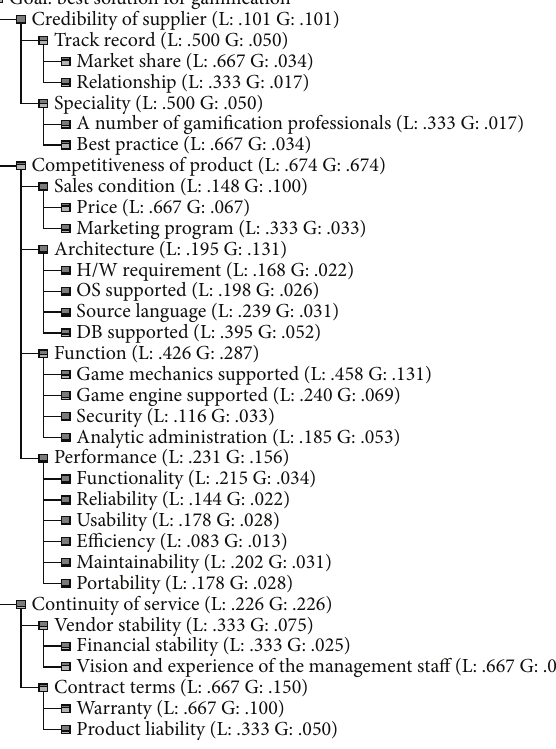
Figure 1: Weights of decision criteria for gamification